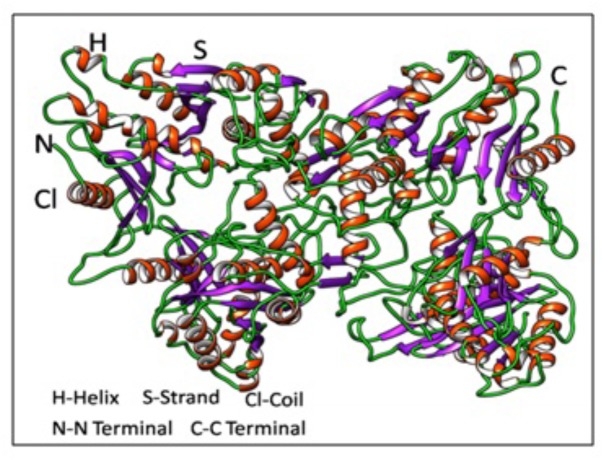
Predicted structure of cysteine protease shows rainbow colored cartoon representation; Helices, Coil and Strands are labeled.